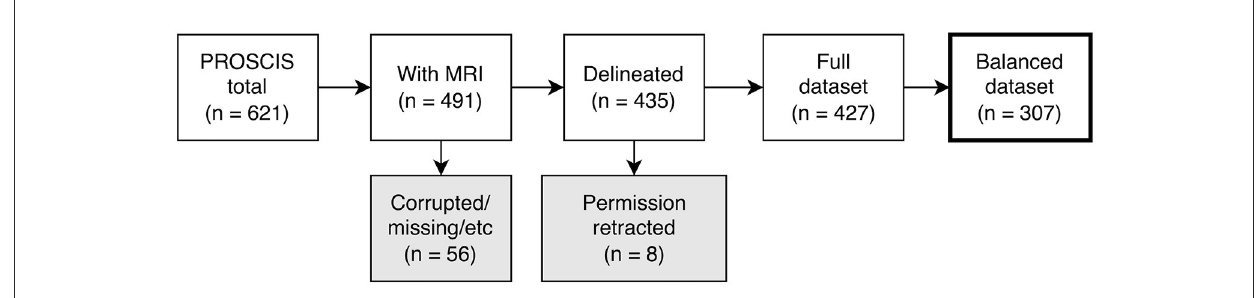
FIGURE1 Flowchart depicting patient selection process. PROSCIS, PROSpective Cohort with Incident Stroke; MRI, Magnetic resonance imaging.